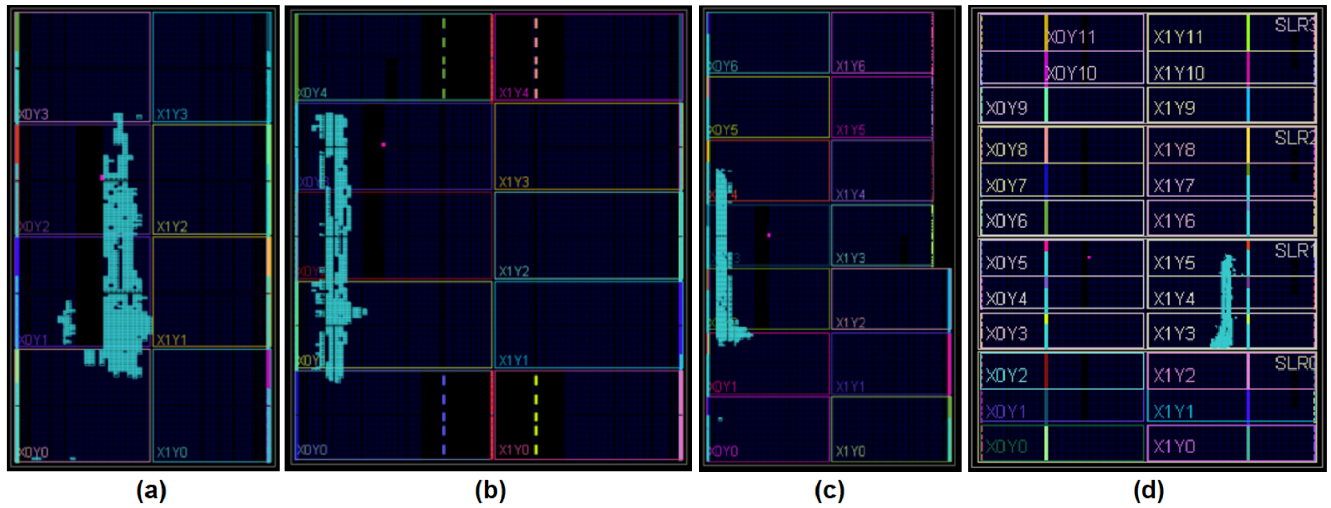
Fig 6. Fitting the SP design into the different devices. (a) Spartan-7 , (b) Artix-7 , (c) Kintex-7 , and (d) Virtex-7 .